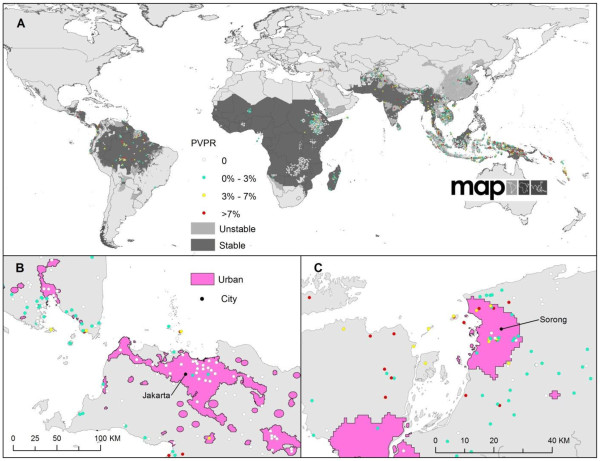
The global spatial limits of P .vivax malaria transmission in 2009[[15]]. Panel A shows the spatial limits of P. vivax malaria risk defined by P. vivax annual parasite incidence (PvAPI) data. Areas were defined as stable (dark grey, where PvAPI ≥0.1 per 1,000 pa), unstable (medium grey, where PvAPI < 0.1 per 1,000 pa) and no risk (light grey, where PvAPI = 0 per 1,000 pa). The community-based PvPR surveys are plotted and colored based on their values (red, where PvPR >7%; yellow, 3% < PvPR <7%; light blue, PvPR < 3%) with zero-valued surveys shown in white. Panel B and Panel C are close-ups for regions with plenty of PvPR surveys with Panel B showing the area around Jakarta, Indonesia and Panel C showing the areas around Sorong, Indonesia.